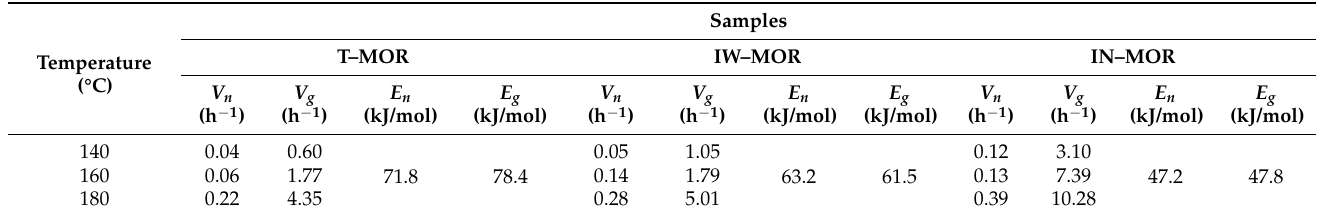
Table 2. Nucleation rate, crystallization rate, activation energy for nucleation ( E n ) and crystal growth ( E g ) of MOR